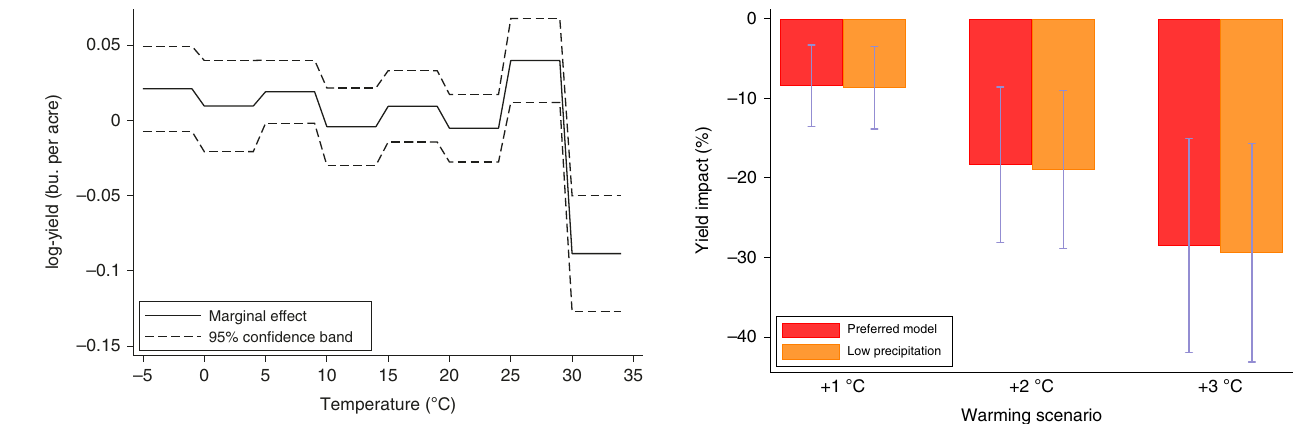
Fig. 4 Warming estimates from alternative model that includes interaction of heat and precipitation variables. Impacts are reported as the percentage change in mean yield under + 1 to + 3 °C warming scenarios relative to historical climate. Each 2-bar cluster shows estimates for a given scenario across different regression-model speci fi cations. The preferred model (Supplementary Table 3) does not include an interaction between extreme heat (temperatures above 30 °C) and rainfall, while the low precipitation model does. Low precipitation is de fi ned as a rainfall outcome below the 10th percentile of the in-sample rainfall distribution. We construct a dummy variable for this measure and then interact it with the extreme heat variable. Bars show 95% con fi dence intervals using standard errors clustered by province-year for n = 18,881 yield observations.